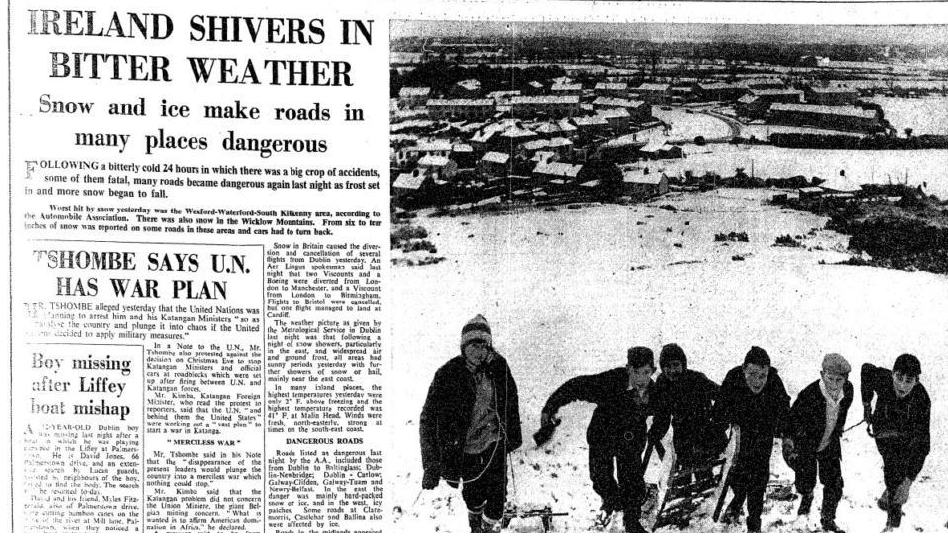
Figure 2. Newspaper consulted during the manual assessment of flagged data [31].